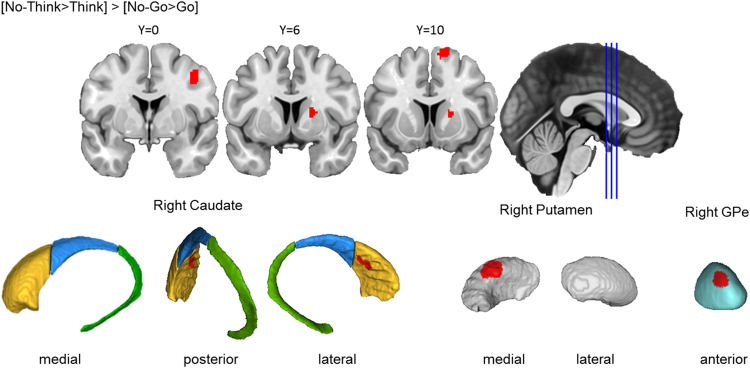
Memory inhibition engaged caudate, putamen, and GPe more reliably than action prevention. Top row: Clusters are presented on coronal slices of a high-resolution MNI atlas. Reference lines for the coronal slices are presented in the sagittal plane. Bottom row: Clusters are displayed on high-resolution parcellations of the caudate, putamen, and external globus pallidus (GPe). All clusters are thresholded using cluster-level inference (p<.05, uncorrected p<.001, threshold permutations=1000).